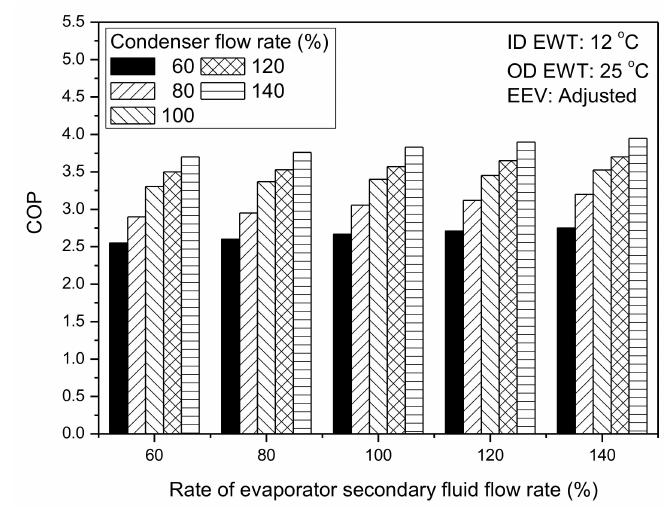
Figure 7. COP with combined evaporator SFFR and condenser SFFR faults.